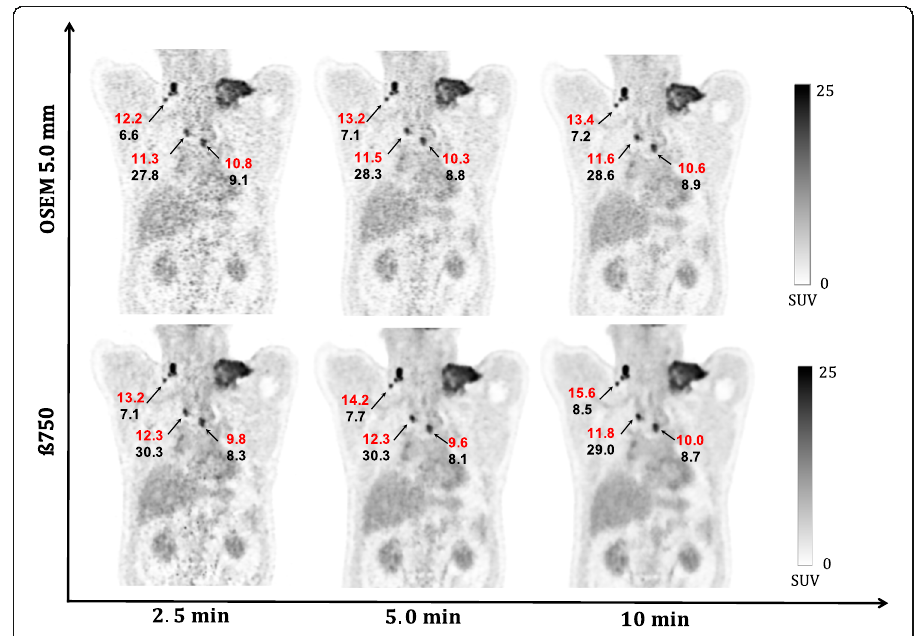
Fig. 7 Coronal whole-body 18 F-FDG PET images of patient with multiple lesions of different sizes of B cell lymphoma. The arrows indicate the SUV mean (red) and MATVs (black) of the lesions. Images were reconstructed using BSREM with β = 750 (including PSF and TOF) and OSEM PSF TOF (3 iterations and 16 subsets and 5 mm gaussian filter) for 2.5, 5.0, and 10